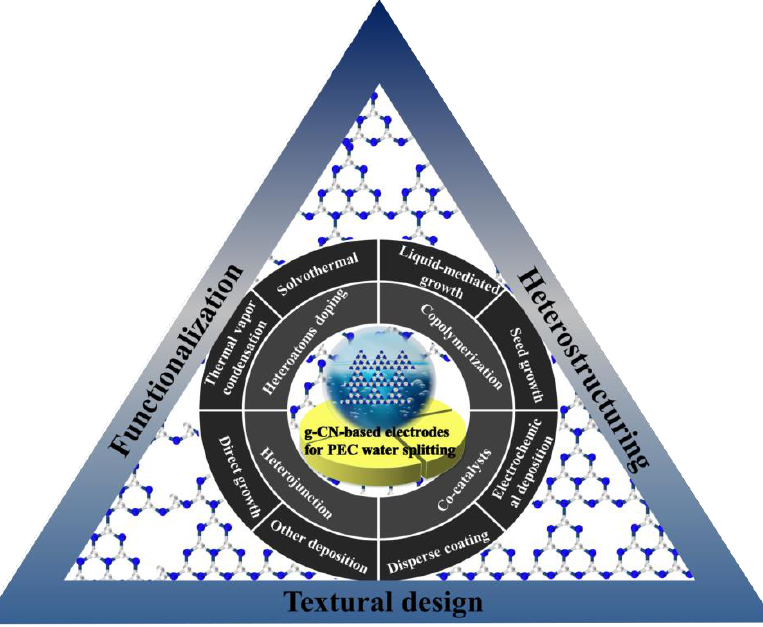
Figure 29. Schematic illustration of the topics involved in this